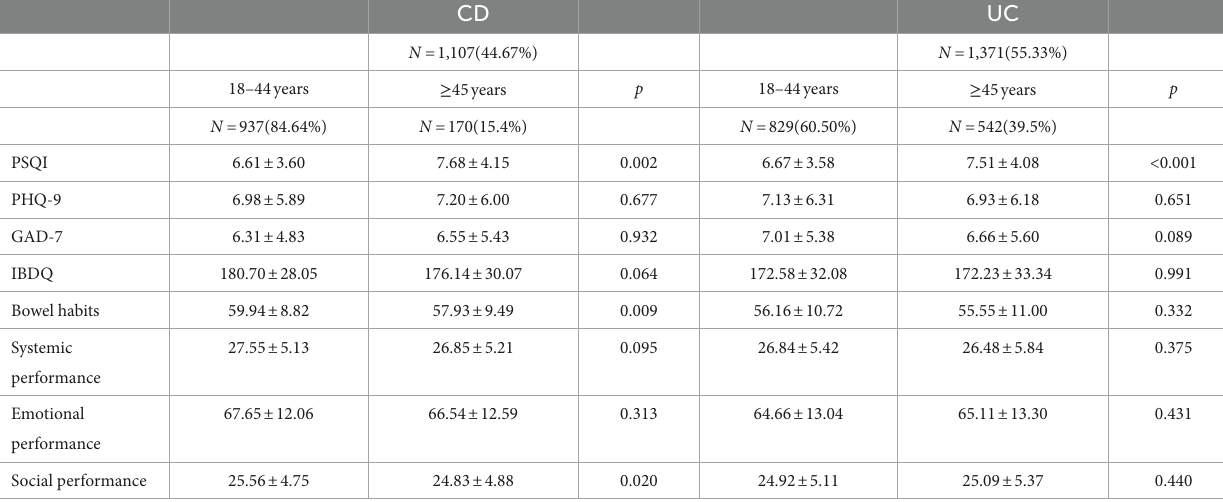
TABLE 2 PSQI, PHQ-9, GAD-7 and IBDQ scores in IBD patients of different age groups. CD UC N = 1,107(44.67%) N =